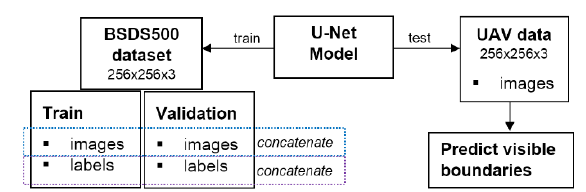
Figure 2. The generalized workflow of the trained model based on U-Net